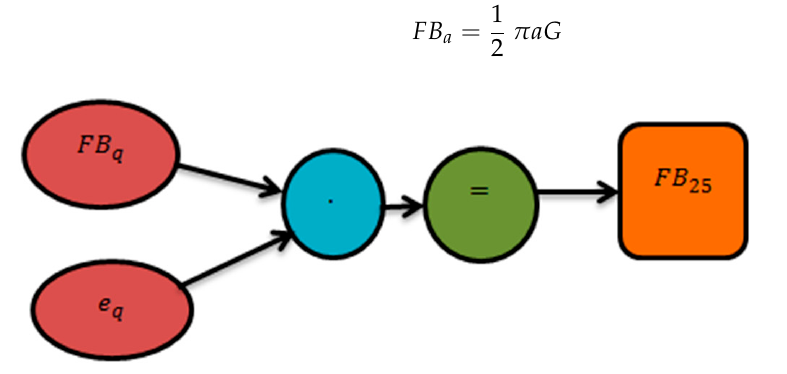
Figure 7. Temperature